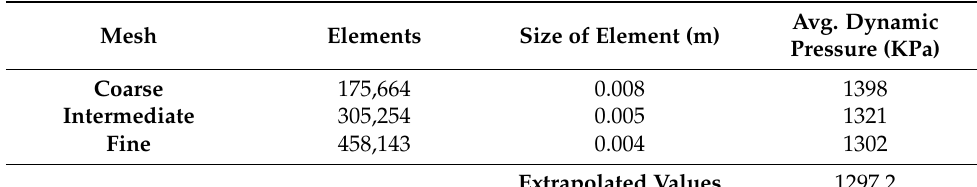
Table 1. Mesh details and convergence criteria.